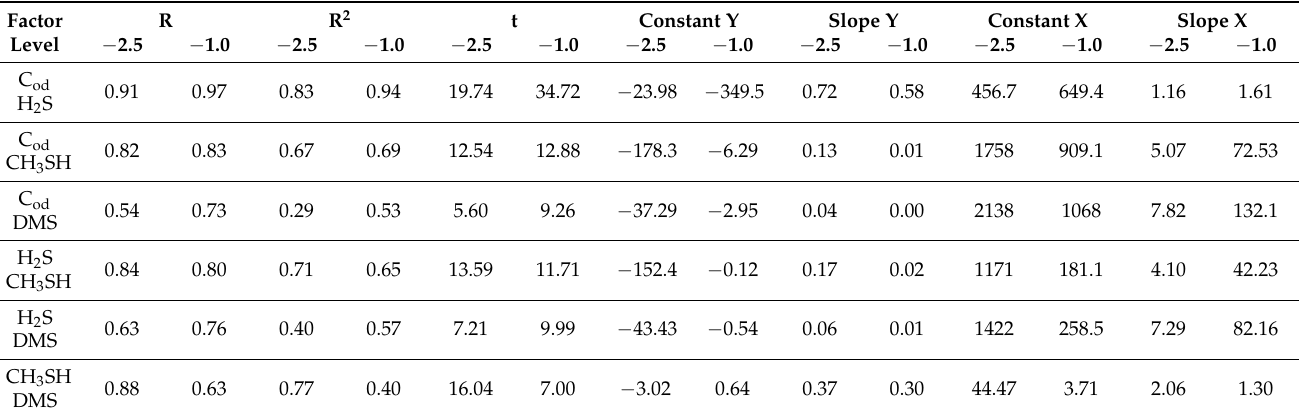
Table 4. Correlation coefficients and basic regression parameters of variables: c od and concentrations of individual